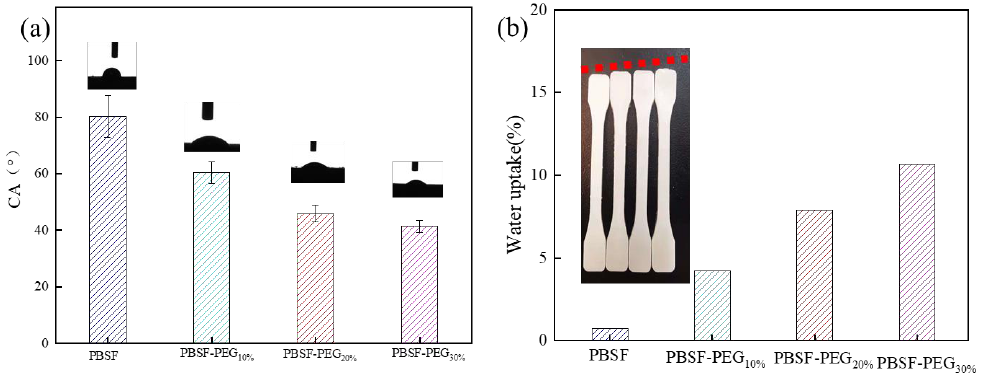
Figure 7. ( a ) Water contact angle (WCA) for the copolymer series with PEG 2000 and ( b ) water uptake percentage with time of PBSF-PEG.